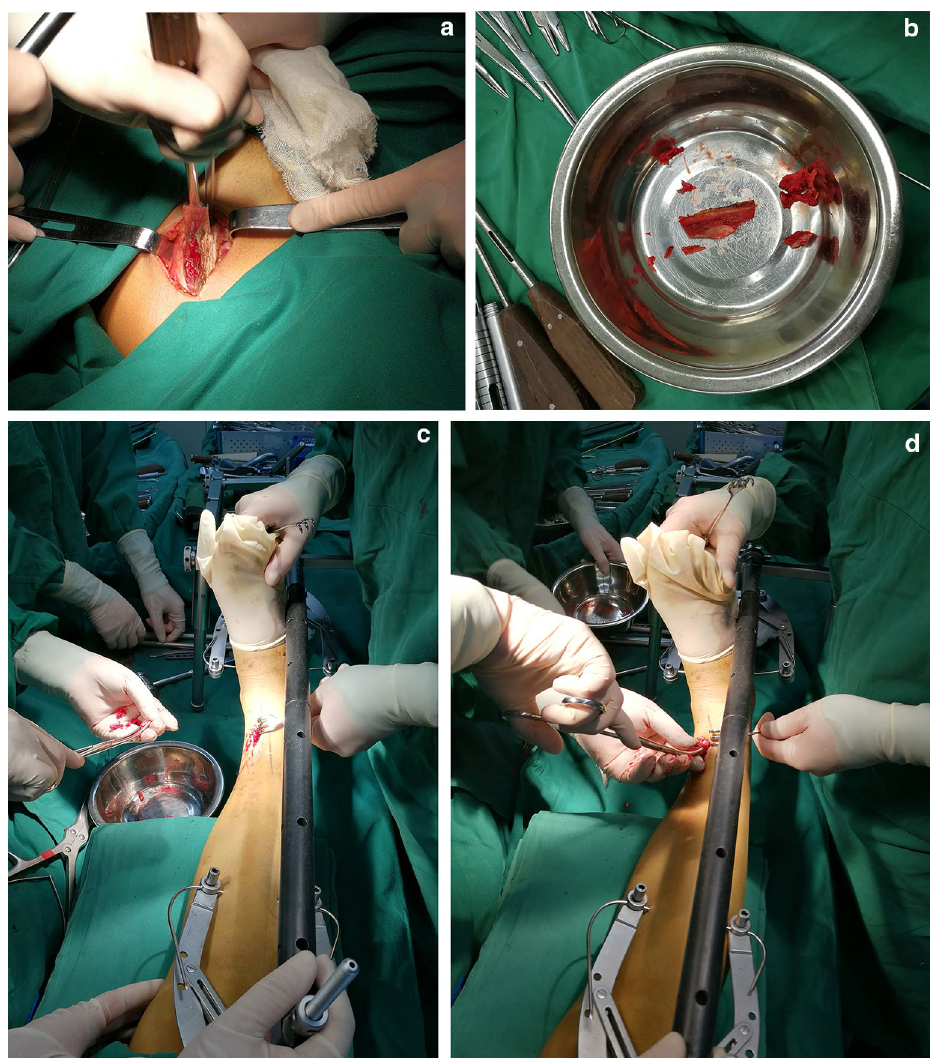
Figure 2. The key messages of autologous iliac crest graft. ( a ) The autologous bone graft was obtained from the contralateral iliac bone. ( b ) The superior and lateral cortex were preserved in the transplanted bone. ( c ) The cancellous bone fragments was implanted. ( d ) the suitable length and diameter of bicortical iliac bone was